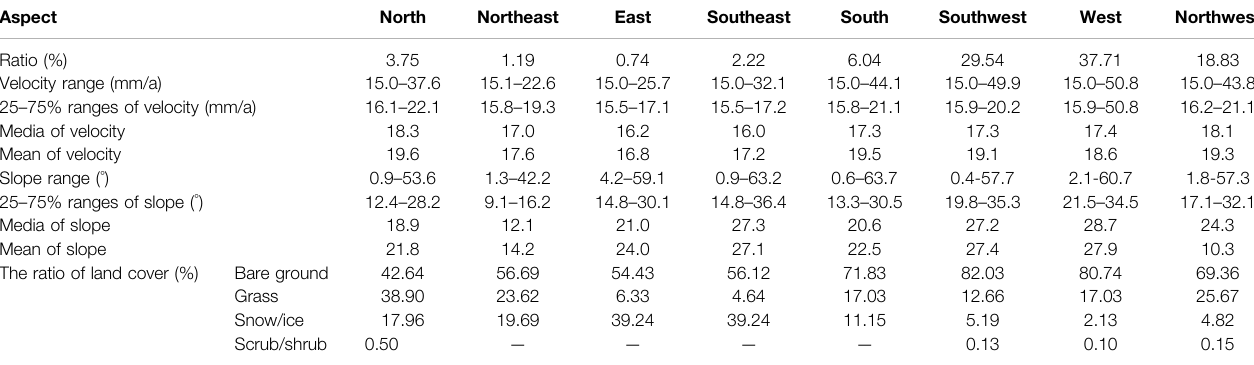
TABLE 4 | Characteristic statistics of areas with the deformation rate greater than 15.0 mm/a.